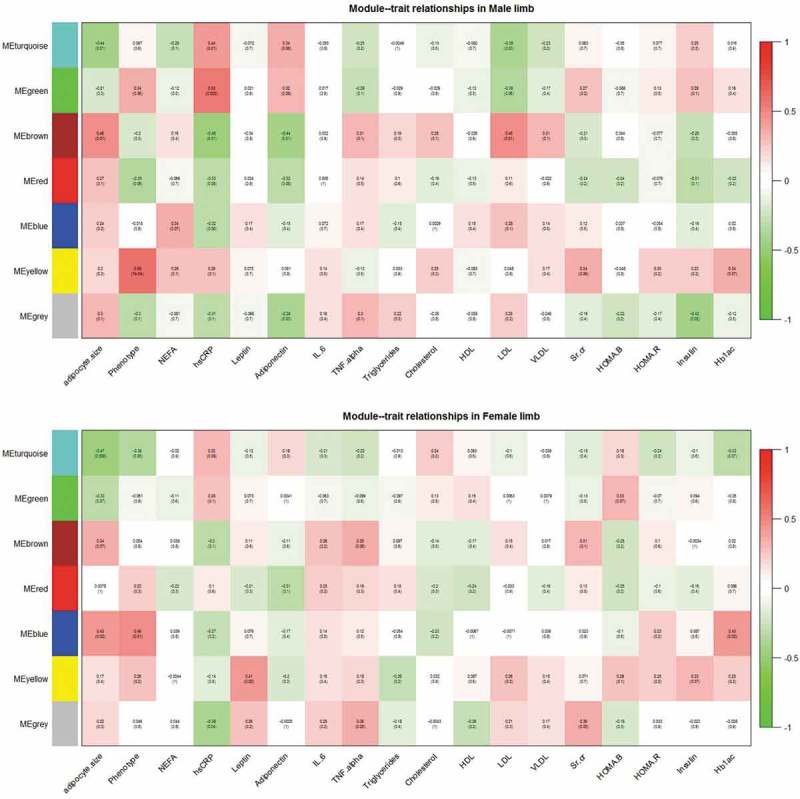
Module-trait relationships in the male and female limb datasets.